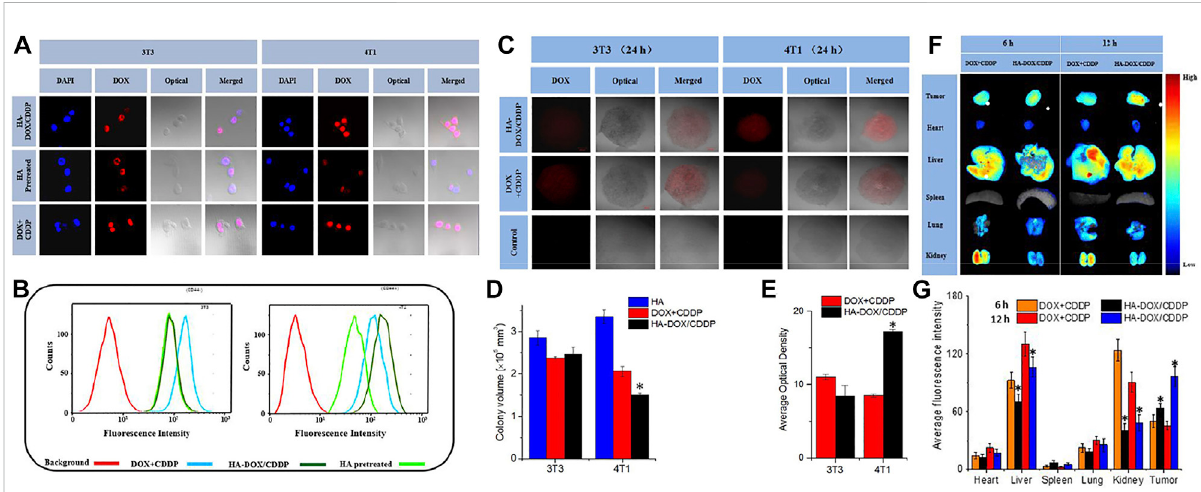
FIGURE 3 In vitro cellular uptake and intracellular DOX release in 3T3 and 4T1 cells. (A) Confocal laser scattering microscopy and (B) FCM analysis were performed on 3T3 and 4T1 cells following HA pretreatment, and treatment with free DOX + CDDP and HA-DOX-CDDP. In vitro multicellular spheroids in3Dsuspensioncultures. (C) Confocal laserscatteringmicroscopy of4T1 and3T3 cell spheroids treatedwith HA, DOX+ CDDP, and HA- DOX-CDDPfor24 h. (D) Colonyvolumeand (E) fl uorescencedensityanalysesof4T1and3T3cellspheroidstreatedwithHA,DOX+CDDP,and HA-DOX-CDDP for 24 h (* p < 0.05 compared with the DOX + CDDP group). In vivo DOX biodistribution. (F) Ex vivo fl uorescence images of isolated organsandtumorsat6or12 hpost-injection. (G) Semi-quantitativeanalysisofthemean fl uorescenceintensityinisolatedorgansandtumorsat6or 12 h post-injection. Data are presented as the mean ± SD ( n = 3) (* p < 0.05 compared with the DOX + CDDP group). Reproduced with permission from ref (Owen et al., 2012). CC BY 4.0. Copyright 2020 The Authors.